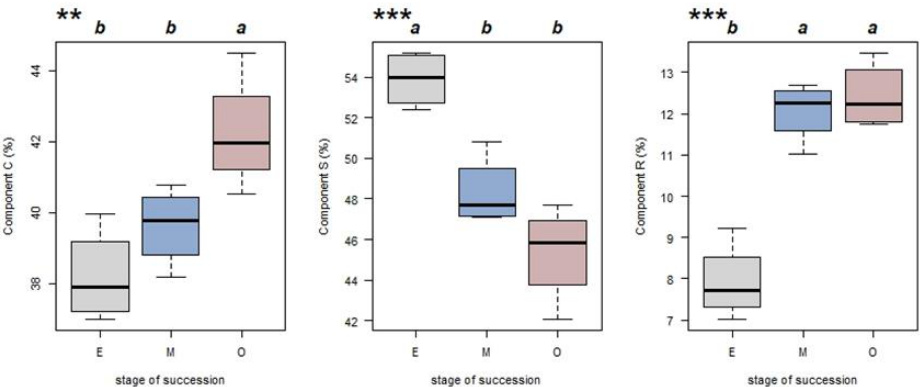
Figure 4. CWM-CSR values (for C, S and R strategy components) for tropical lowland rainforest stands on Hainan Island at different successional stages (gray, E, early succession; blue, M, mid- succession; and red, O, late succession). ** p < 0.05 and *** p < 0.01 indicate significant differences according to a one-way ANOVA ( n = 4). Different letters indicate significant differences between stages (Tukey’s test; p < 0.05).